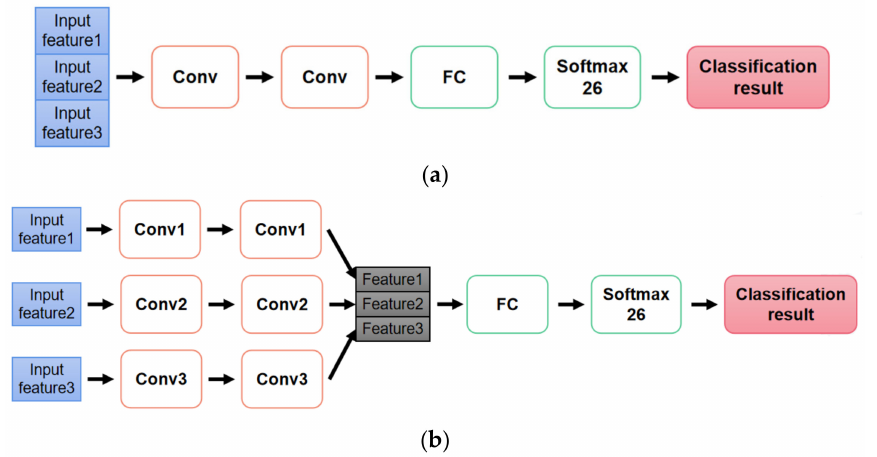
Figure 6. Classification models with multi-features as input. ( a ) Early fusion model. ( b ) Late fusion